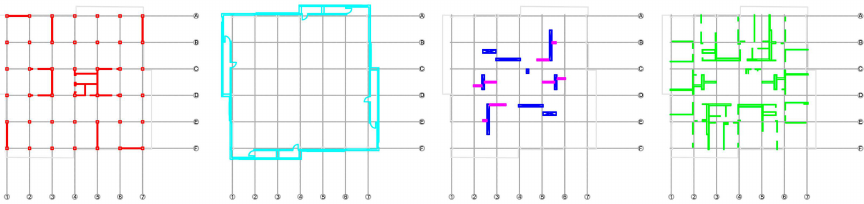
Figure 13. Block 70—building B + 8: Building model decomposition into main functional and technical levels: load-bearing, façade, services and partitions.